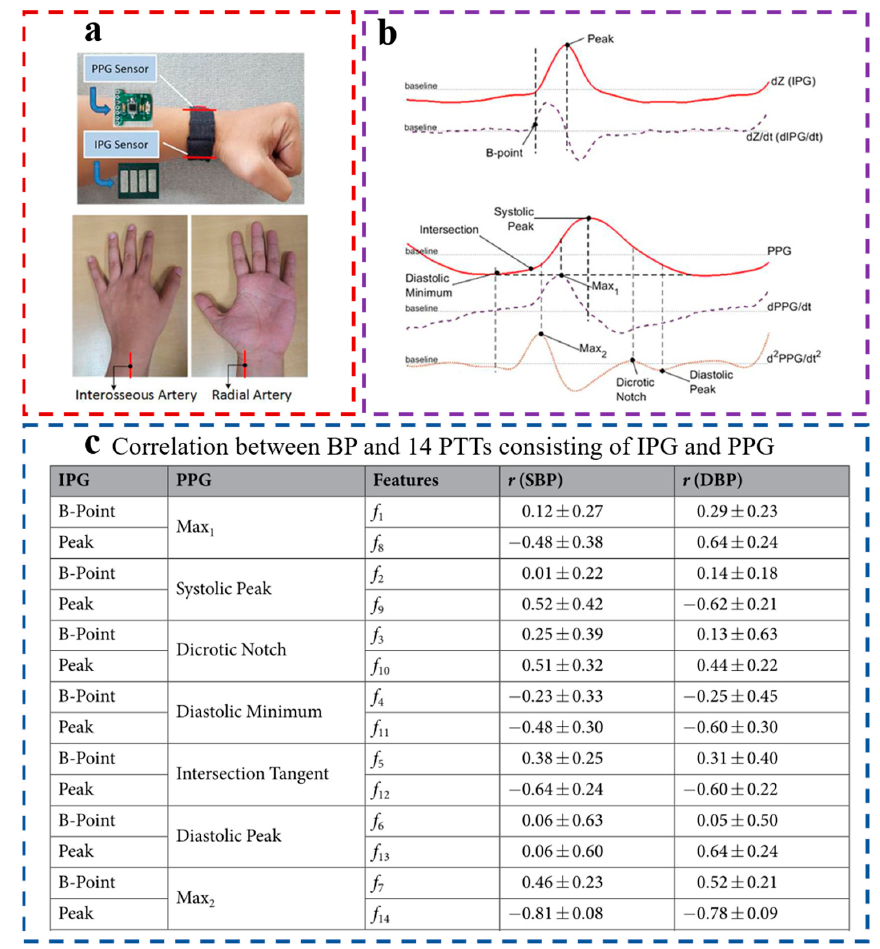
Figure 13. ( a ) Multimodal biosensor with the IPG signal and PPG signal; ( b ) Overall detected reference points; ( c ) Different PTT feature correlation coefficient values with SBP and DBP values. Reproduced with the permission of [72].